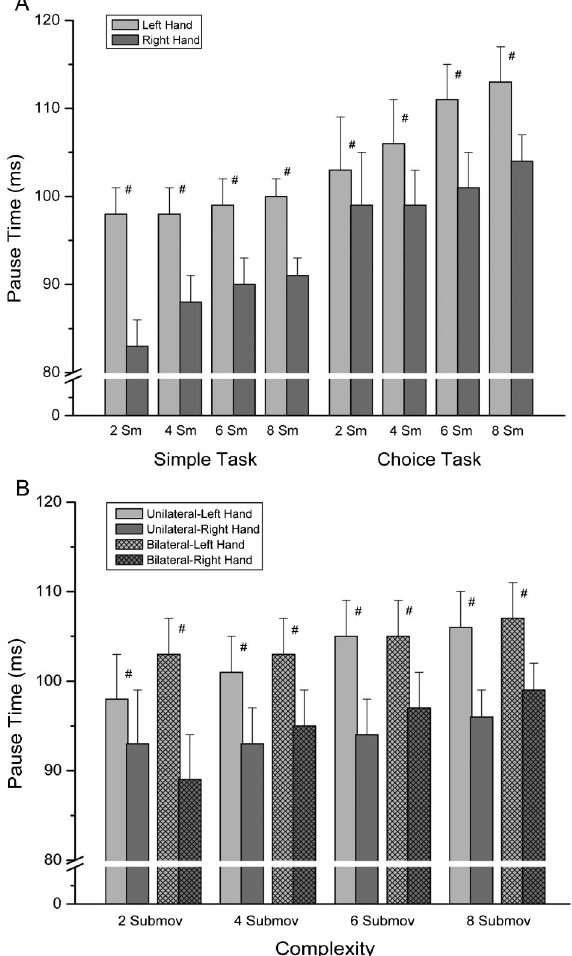
Figure 4. Left hand and right hand pause times in milliseconds for the four complexity levels in the simple and choice tasks ( panel A ) and the unilateral and bilateral responses for the four complexity levels ( panel B ). Data are reported as means±SE for 16 participants. Sm/Submov: submovements. # P , 0.05 compar- ing left and right hands (repeated measures analysis of variance followed by the Tukey